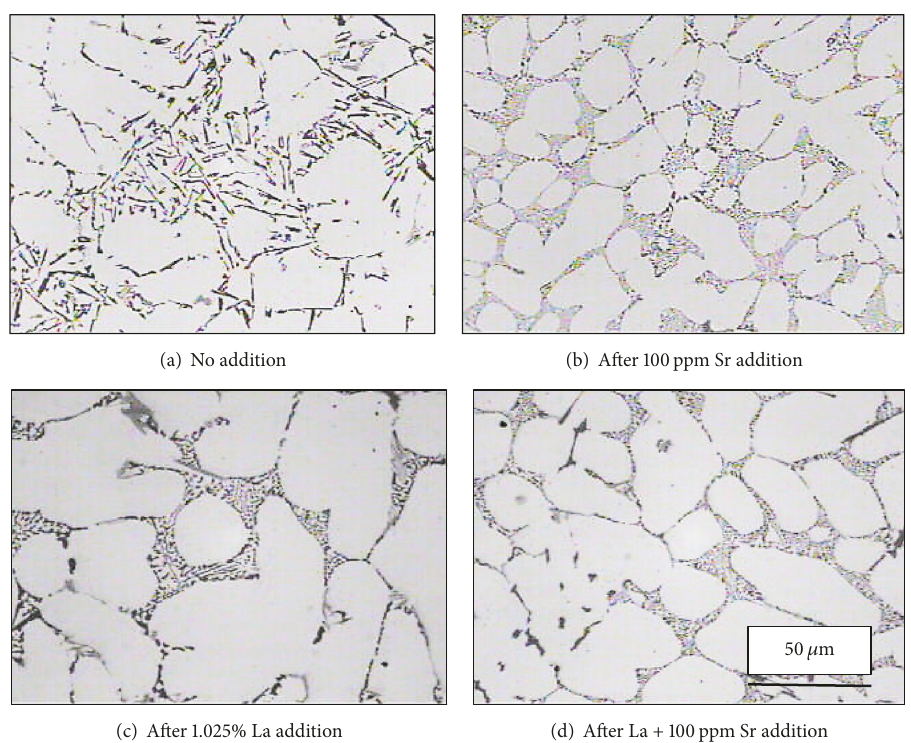
Figure 13: Examples of the eutectic Si particles observed in A356 alloy following addition of Sr, La, or Sr + La in samples obtained from the small section (200 ∘ C) of the step-like mold casting.